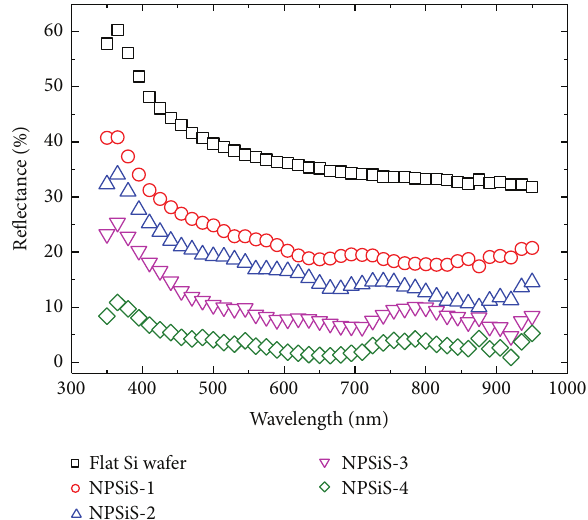
Figure 4: Reflectance spectra of flat c-Si wafer and NPSiS wafers obtained using integrated sphere